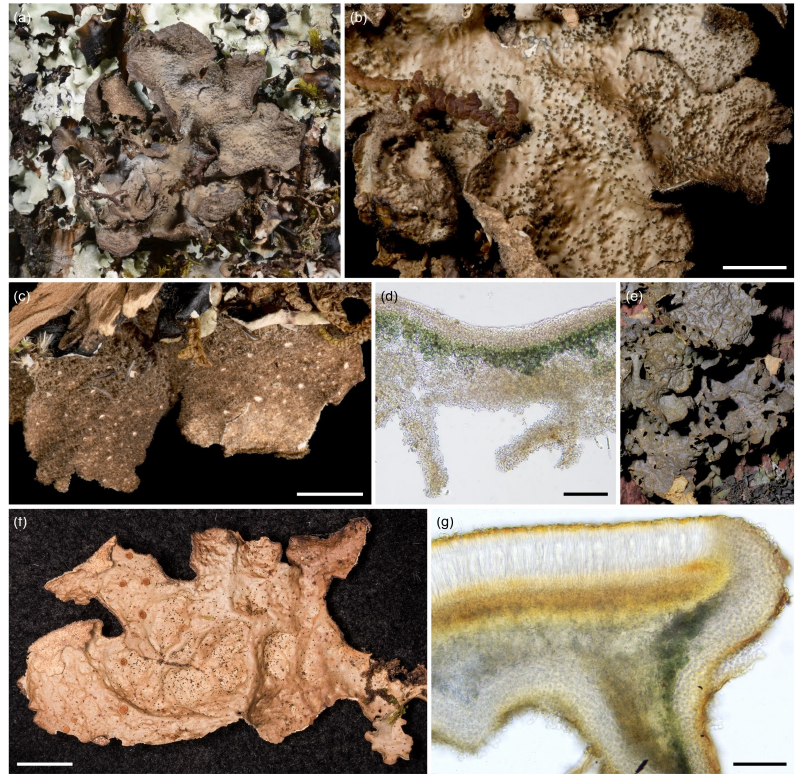
Figure 8. Sticta aspratilis . ( a – d ) Type specimen JR16107. ( a ) Photographed in situ in the ericaceous zone on Mt. Elgon. ( b ) The uneven and isidiate upper surface. ( c ) Abundantly tomentose lower surface. ( d ) Thallus cross section with a cyphella, showing the cyphellar membrane with rounded cells without papillae. ( e ) Specimen JR10155 photographed in situ on Yale, with gray and distinctly reticulate upper surface. ( f , g ) Fertile specimen UK171478a. ( f ) Foveolate upper surface with apothe- cia. ( g ) Cross section of an apothecium. Scales 0.5 cm in ( b , c ), 100 µm in ( d , g ), 1 cm in ( f ). Description: Thallus rosetteform to irregular, attached to substrate from the center of the lower side. Lobes 130–250 µm thick, loosely adnate, rarely ascending, usually rounded palmate, usually 2–4 cm wide and 2–3 cm long, but sometimes more elongate and up to 7 cm long; branching polytomous, margins entire to sinuose, sometimes slightly crisped with isidia, occasionally revolute. Upper surface grey–brown or more rarely brown, usually at least slightly glossy, uneven, ridged (isidiate specimens) and/or foveolate, with occa- sional eroded patches surrounded by isidia. Upper cortex paraplectenchymatous, 25–60